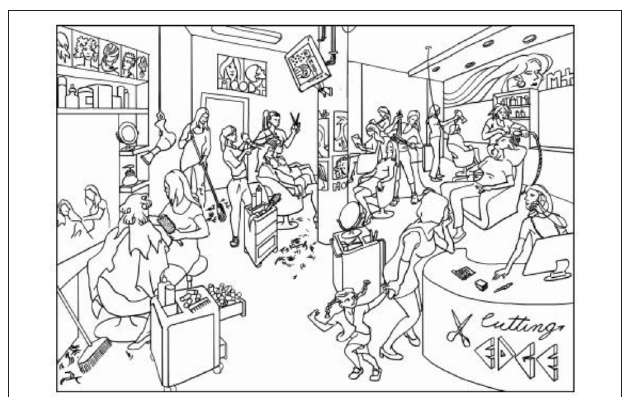
FIGURE 7 | Cutting edge (Maurizio Modena,